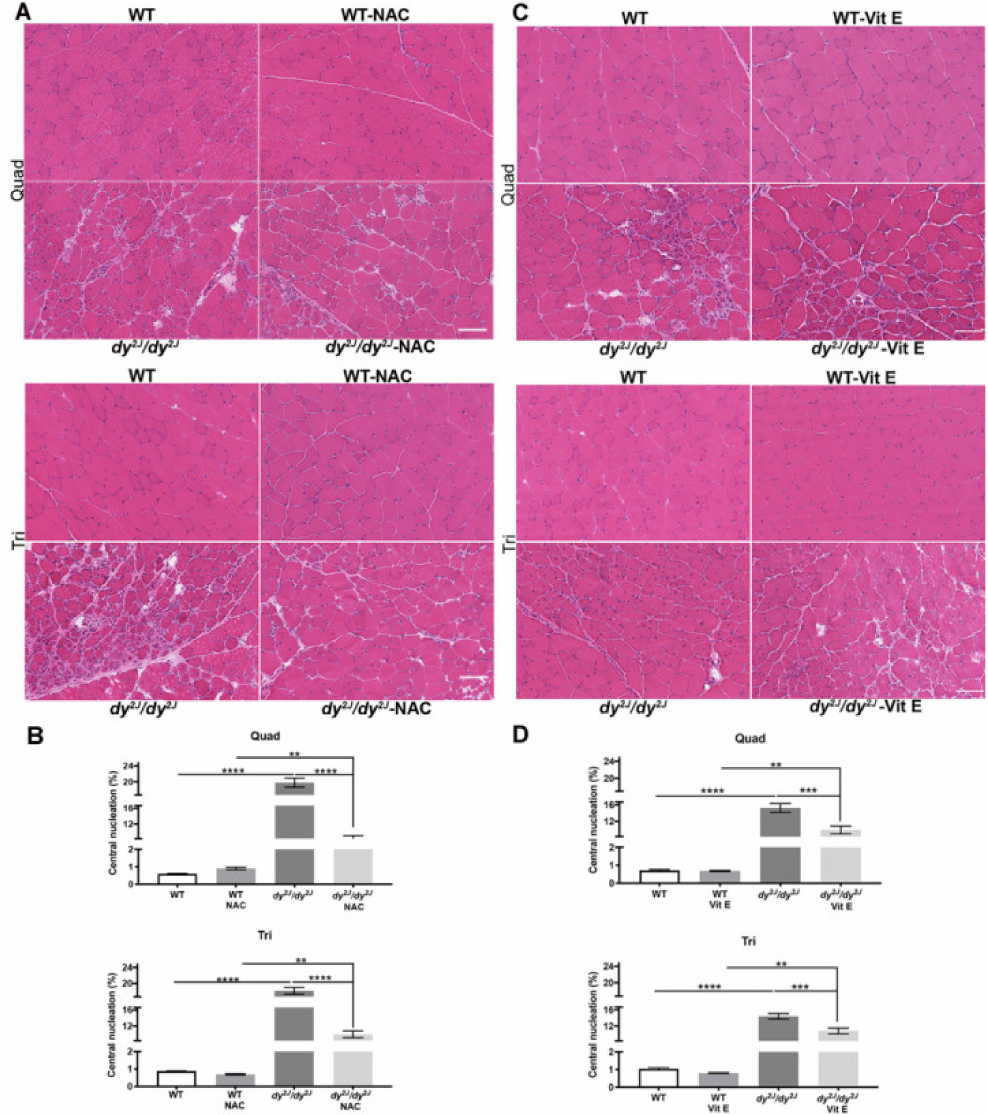
Figure 3. ( A ) Representative hematoxylin and eosin-stained quadriceps and triceps muscle sections (NAC treatment); ( B ) Number of centrally nucleated myofibers in 8 WT, 10 WT NAC, 5 dy 2J / dy 2J , 6 dy 2J / dy 2J NAC quadriceps and triceps muscles. Results are expressed as mean ± SEM. ( C ) Representative hematoxylin and eosin-stained quadriceps and triceps muscle sections (vitamin E treatment); ( D ) Number of centrally nucleated fibers in 6 WT, 5 WT vit E, 5 dy 2J / dy 2J , 5 dy 2J / dy 2J vit E in quadriceps and triceps muscles. Results are expressed as mean ± SEM. ** p < 0.01, *** p < 0.001 and **** p < 0.0001. Bars: 100 µ